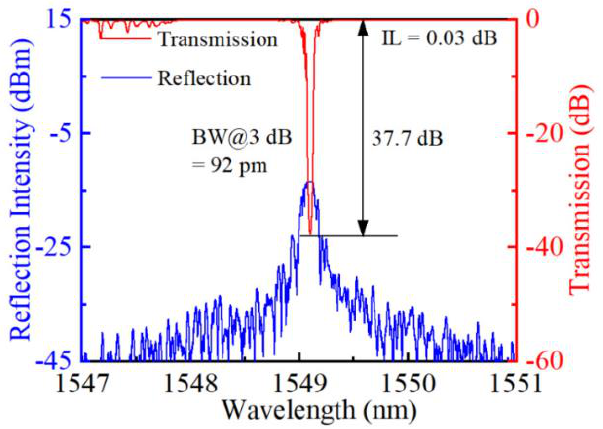
Figure 5. Transmission and reflection spectra of the inscribed 40 mm long first-order FBG.